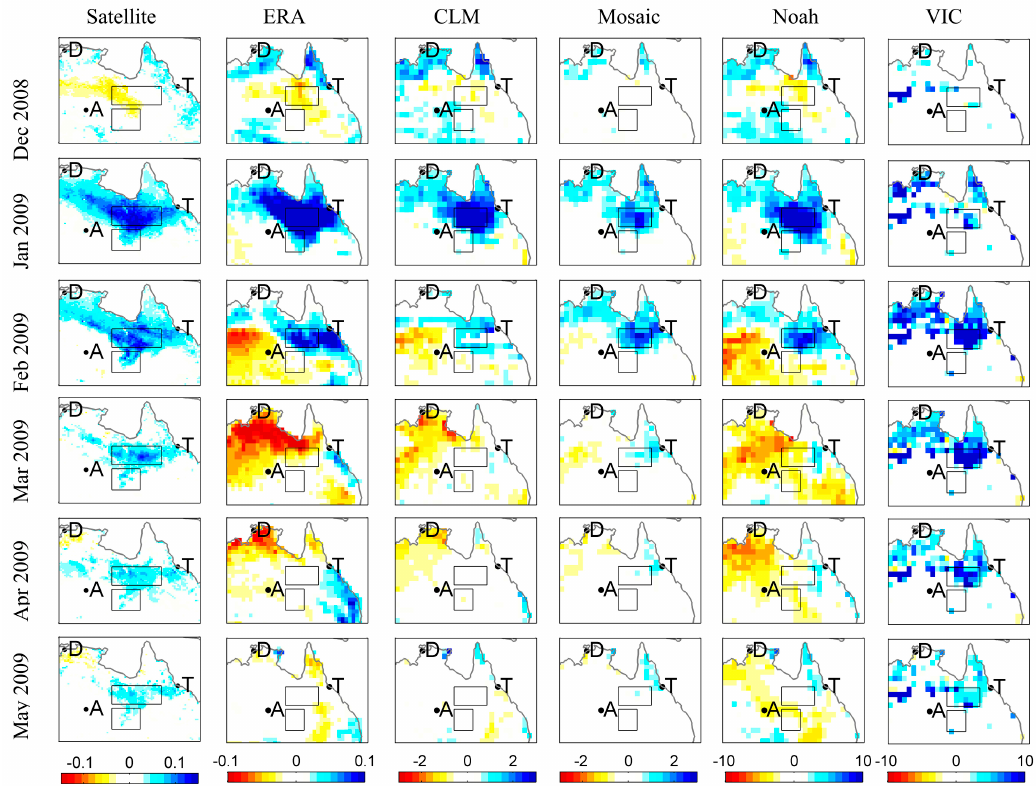
Figure 6. Similar to Figure 2 with results from satellite soil moisture, ERA Interim/Land, and GLDAS models (CLM, Mosaic, Noah, and VIC) shown in the columns from left to right. See the codes at the top of each column of panels. The unit of ERA Interim/Land soil moisture is m 3 /m 3 , and GLDAS models use the unit of kg/m 2 . The scale differences are mainly caused by the depth variations (see Materials and Methods, specifically Table 2).